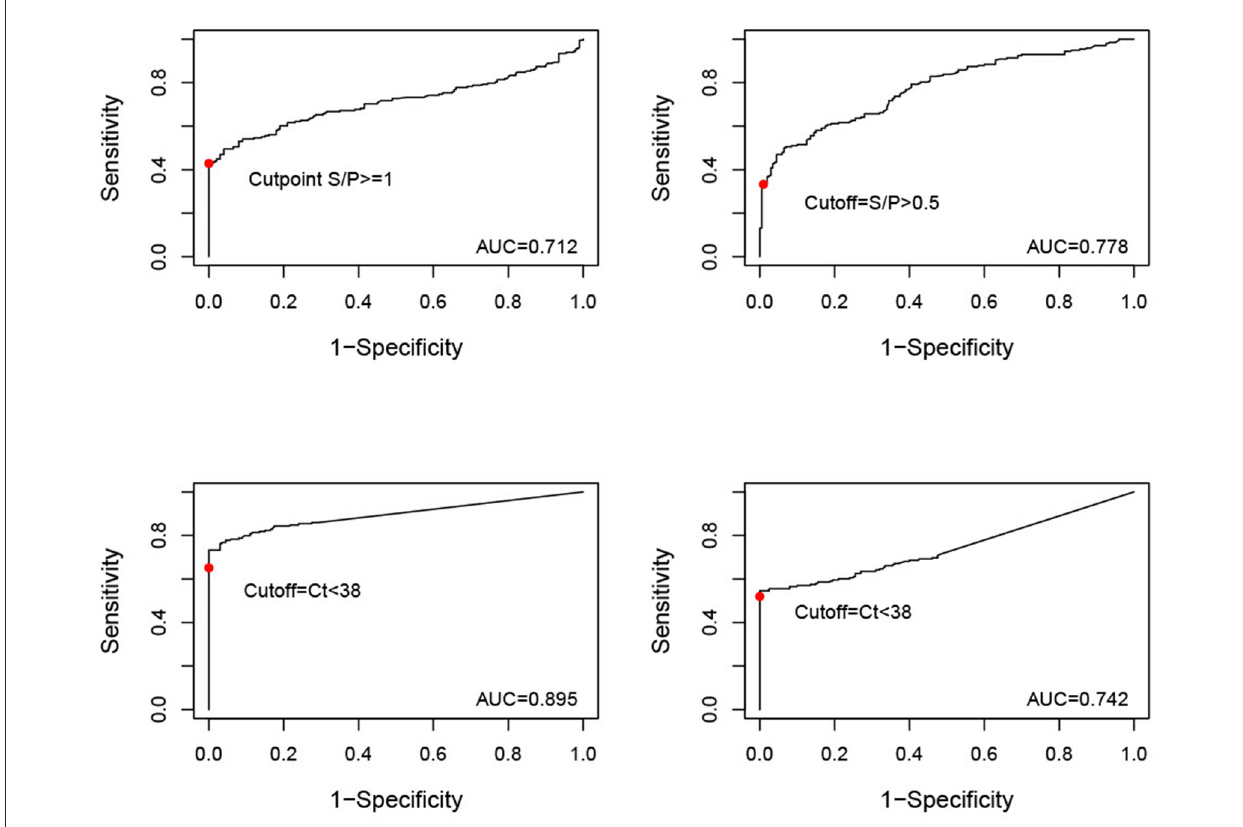
FIGURE2 ROC curves (y = sensitivity, x = 1-specificity) for serum samples tested by iELISA, oral fluid (OF) samples tested by iELISA, serum samples tested by qPCR, and OF samples tested by qPCR. The solid red dot indicates the cut-off value used for analysis (iELISA serum positive = S/P ≥ 1, iELISA OF positive = S/P ≥ 0.5, qPCR serum and OF positive = Ct <